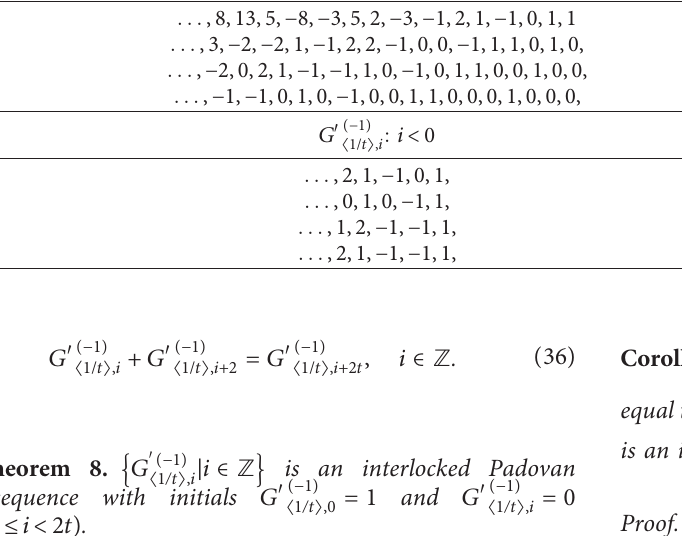
| i ∈ Z 􏼚 􏼛 and G ′ (− 1 ) 〈 t 〉 ,i